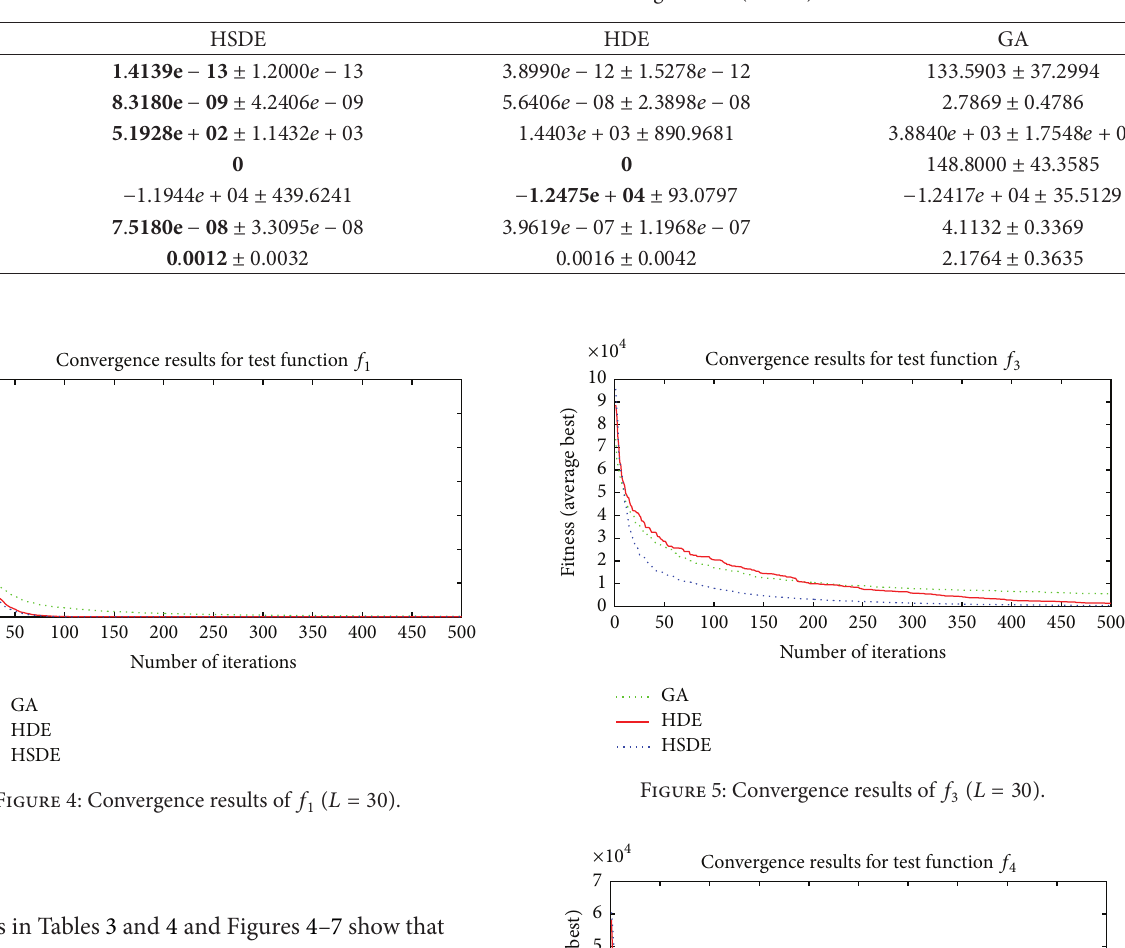
Table 4: Results of seven functions with three algorithms ( 𝐿 = 30 ).